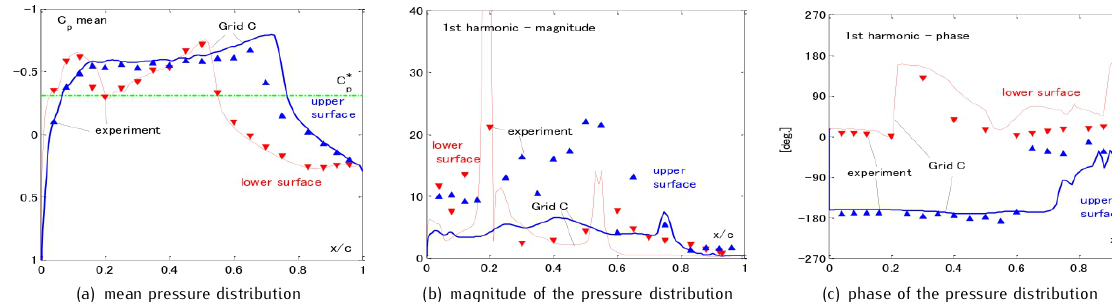
Figure 16. Unsteady pressure distribution (#09245).